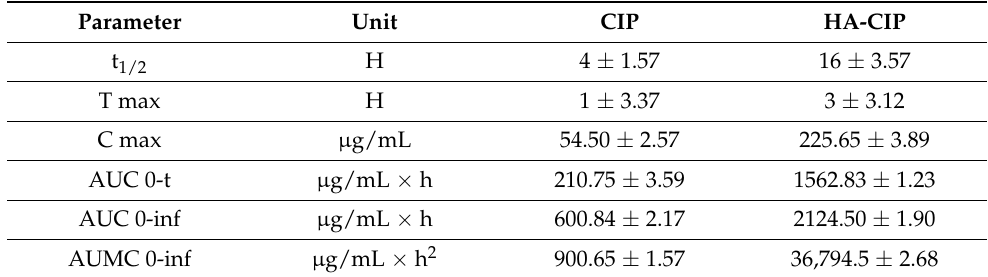
Table 5. Results of in-vivo pharmacokinetic properties after oral delivery of CIP and HA-CIP SNEDDS to